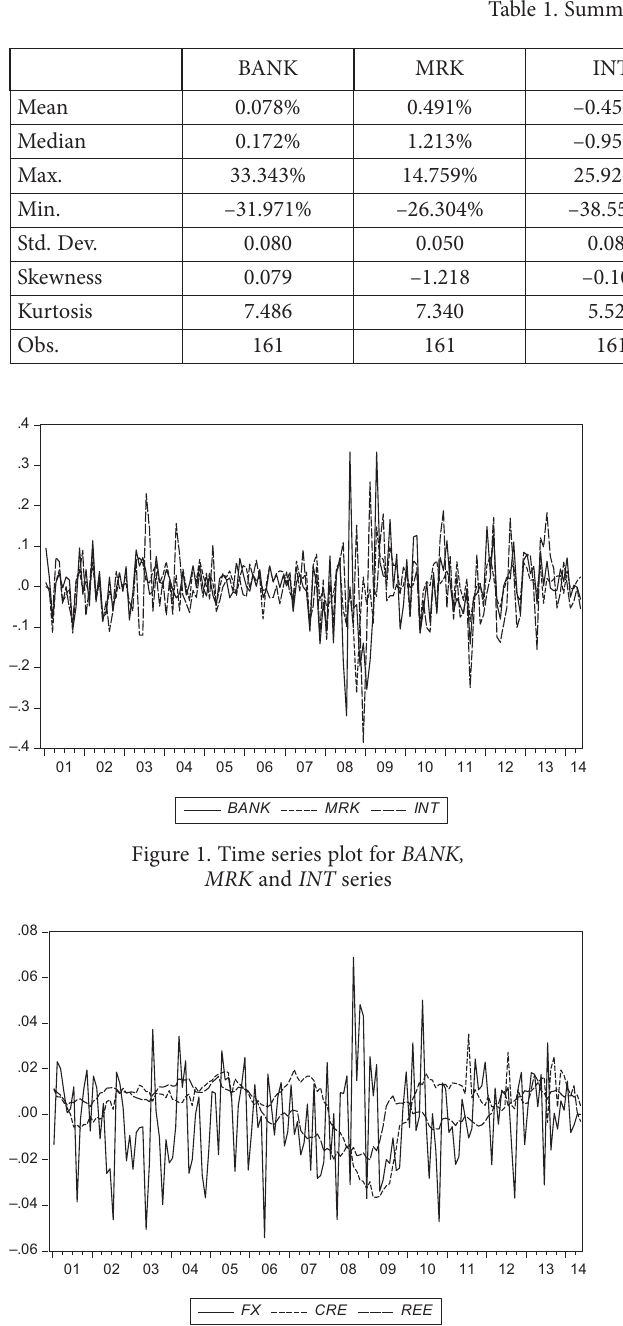
Figure 2. Time series plot for FX, CRE and REE series